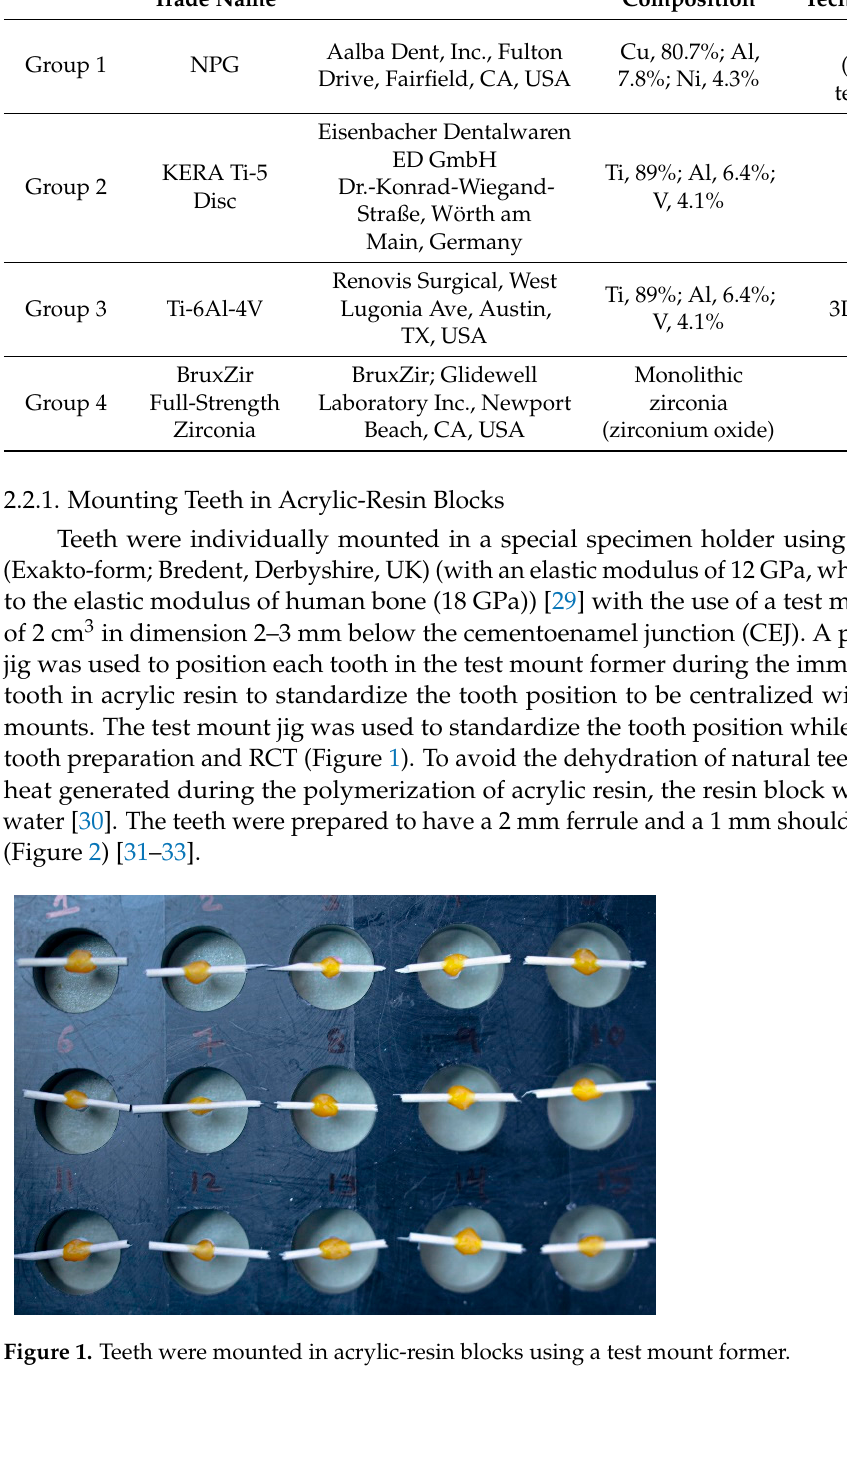
Figure 2. Preparation of tooth to have a 2 mm ferrule and a 1 mm shoulder finish line. ( A ) Occlusal view. ( B ) Lateral view. 2.2.2. Root-Canal Preparation and Obturation Access-cavity preparation was performed using a size 2 diamond round bur on a high-speed handpiece with copious water. The working length was established as 1 mm shorter than the root apex. Root-canal preparation for each tooth was performed up to size 40/0.06 with a Vortex Blue rotary file (Dentsply Sirona, Tulsa, OK, USA) in a crown- down fashion. Canals were irrigated with NaOCl 5.25% and EDTA 17% (chelating agent) (Ultradent Products Inc., South Jordan, UT, USA) to remove organic and inorganic debris and smear layers [34]. Upon completion of the cleaning and shaping and before obtura- tion, the prepared root canals were dried with sterile paper points (Sure-endo, Gyeonngi- do, Republic of Korea). A matching size 40/0.06 gutta-percha master cone (Dentsply Si- rona, Tulsa, OK, USA) coated with AH Plus sealer (Dentsply Sirona GmbH, De-Trey- Straße, Konstanz, Germany) was used for obturation [34]. Root canals were obturated us- ing the warm vertical compaction technique with System-B and Obtura (Kerr/Sybron Endo Corp., Brea, CA, USA). 2.2.3. Post-Space Preparation To obtain a standardized length for the posts, the coronal portion of gutta-percha was removed with System-B (Kerr corporation, Brea, CA, USA) until an adequate length (11 mm) was achieved [35–38]. Definitive post length and width were prepared and estab- lished with the use of Peeso reamers (Maillefer S.A., Ballaigues, Switzerland) up to size 3. Each canal was then cleaned using an air/water spray and EDTA to remove debris and then dried with paper points.